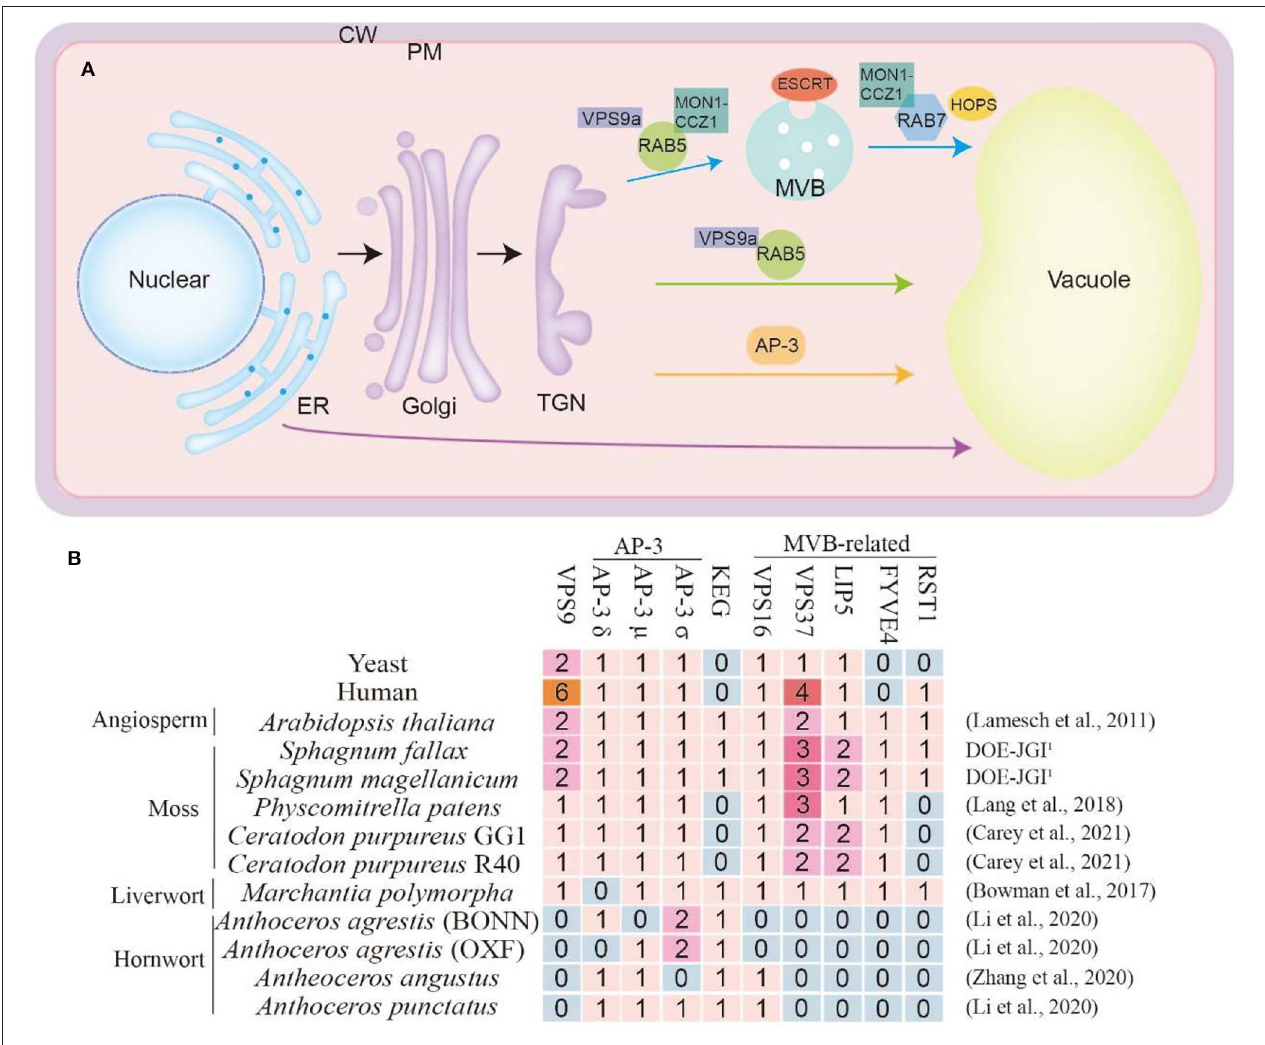
FIGURE 2 | (A) Vacuole trafficking pathway in plants. The blue arrows indicate the pathway mediated by RAB5 and RAB7. The green arrows indicate the vacuole trafficking pathway regulated by RAB5 but do not include RAB7. The orange arrows indicate the AP-3-dependent pathway. The purple arrows indicate the ER to vacuole trafficking pathway. ER, endoplasmic reticulum; Golgi, Golgi apparatus; TGN, trans -Golgi network; MVB, multivesicular body; PM, plasma membrane; CW, cell wall. (B) Some special regulator proteins in bryophytes and species genome databases are used in this article. The complete table was in the Supplementary Tables . The numbers represent the quantity of the ortholog proteins in this species. The genome database reference for Arabidopsis thaliana (Lamesch et al., 2011), P. patens (Lang et al., 2018), C. purpureus (Carey et al., 2021), M. polymorpha (Bowman et al., 2017), A. agrestis (Li et al., 2020), A.